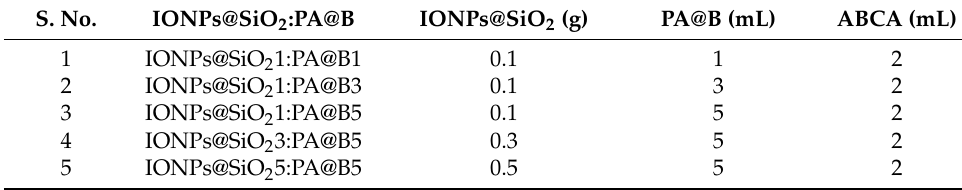
Table 1. Different ratios of IONPs@SiO 2 and PA@B in the synthesis of MCM-PA@B. S.